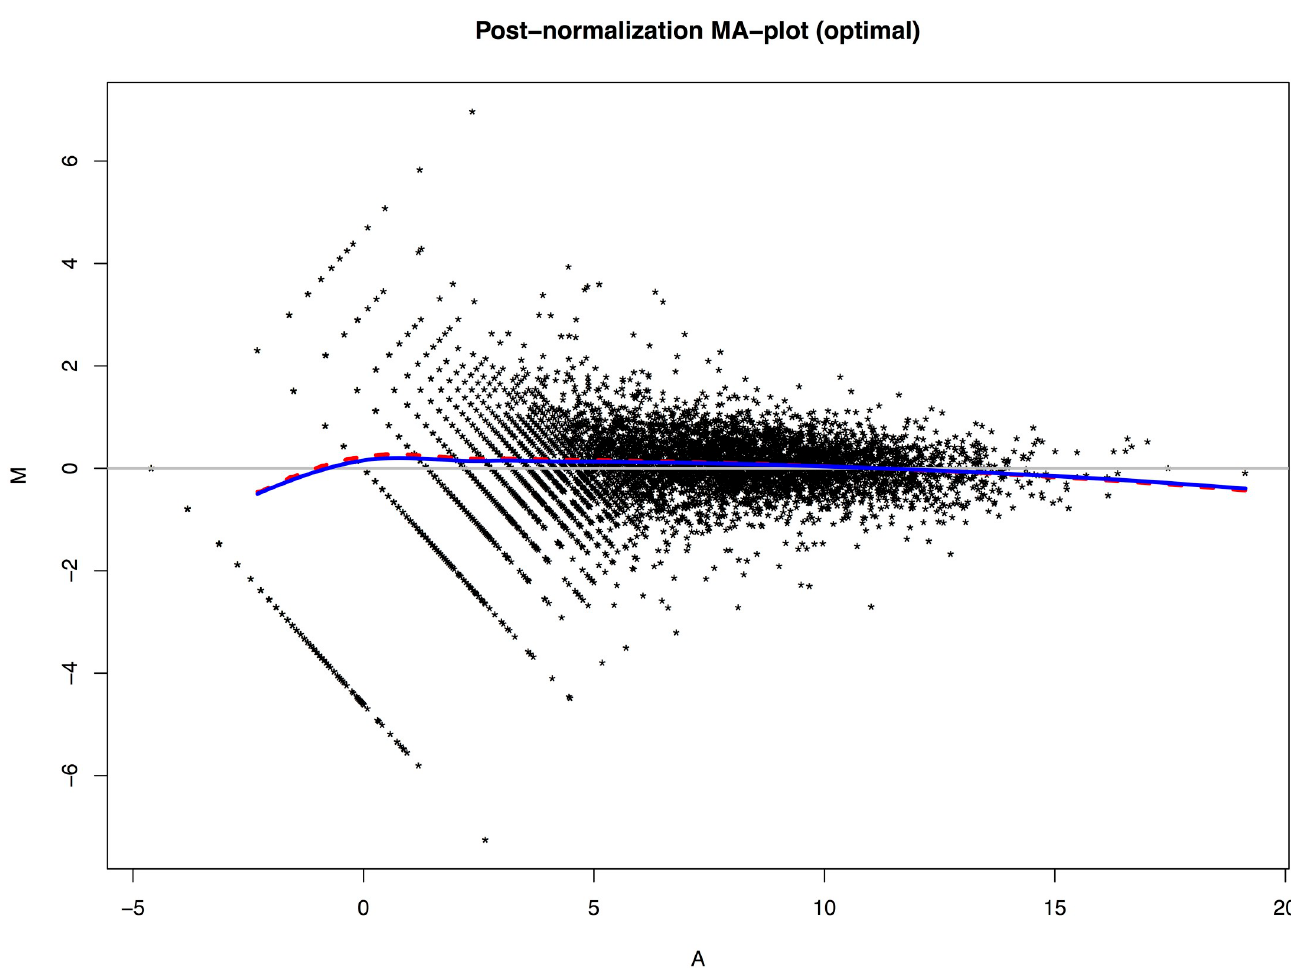
Fig 6. MA-plot after normalization with optimal estimates of ( σ , γ ). The solid curve shows the loess curve based on the data normalized with the optimal estimates, while the dashed curve is the loess curve based on data normalized using the OLS estimates. A smoothing parameter span = 0.2 is used for both